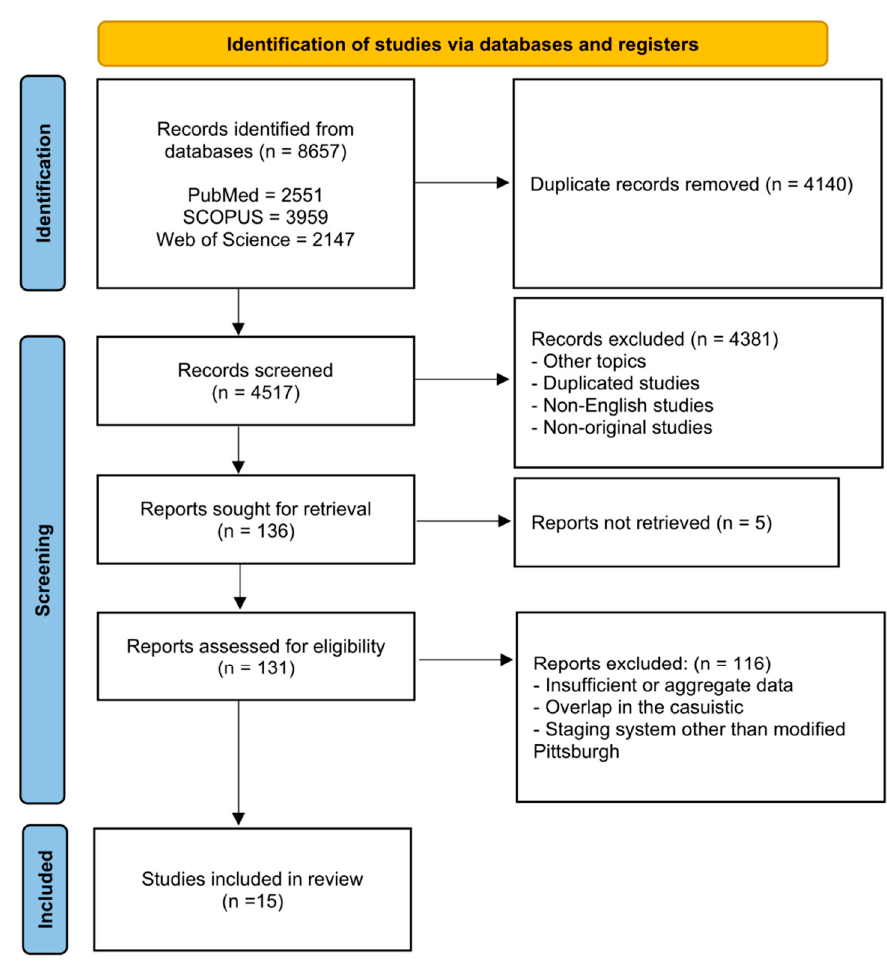
Figure 1. PRISMA flowchart of the study inclusion process. n = Figure 1. PRISMA fl owchart of the study inclusion process. n = number.